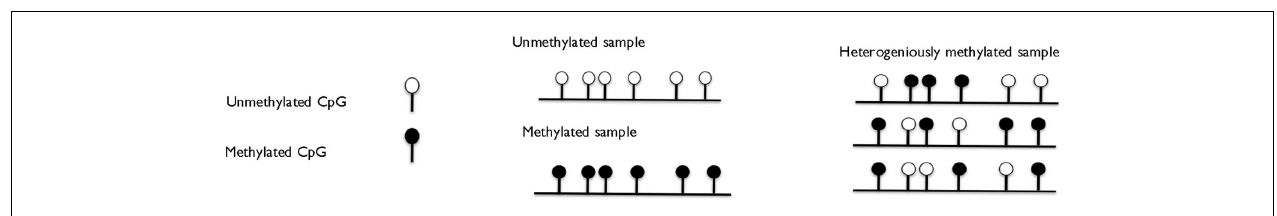
FIGURE 2 |Three stages of methylation of the locus: fully methylated, fully unmethylated, and heterogeneously methylated.